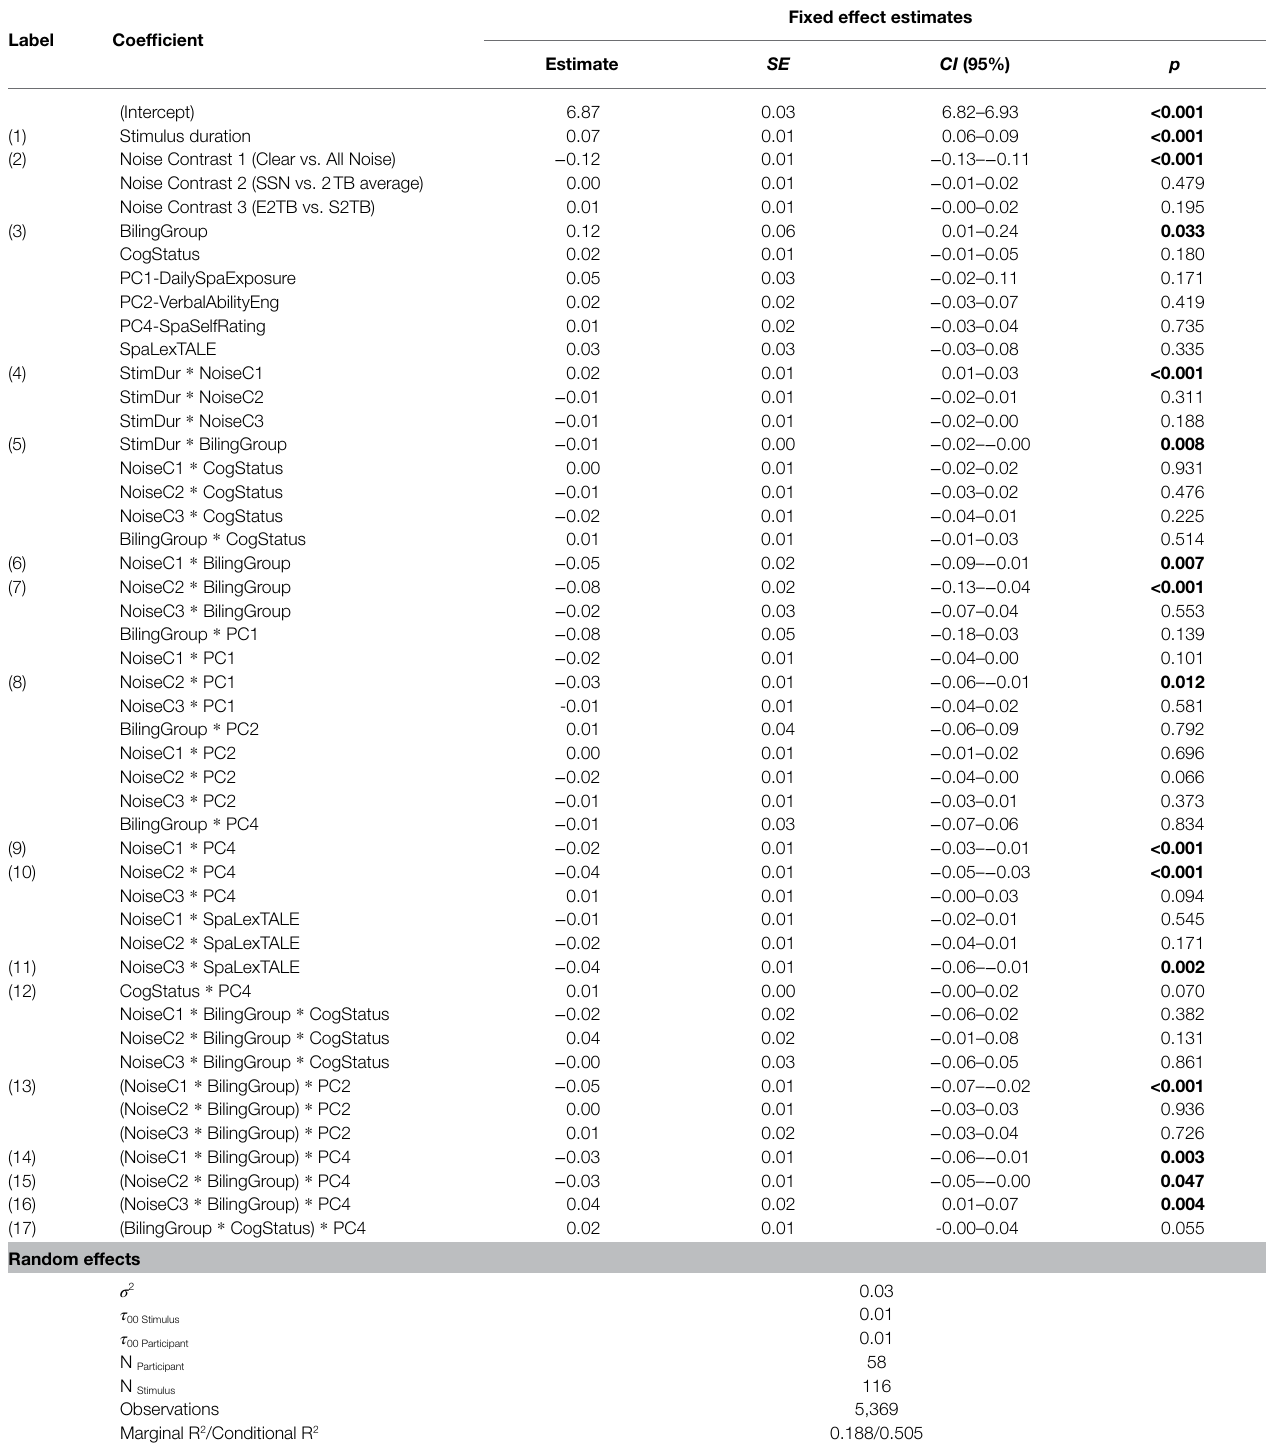
TABLE 8 | Fixed and random effects for the model comparing RTs for bilingual participants only in the individual differences analysis.